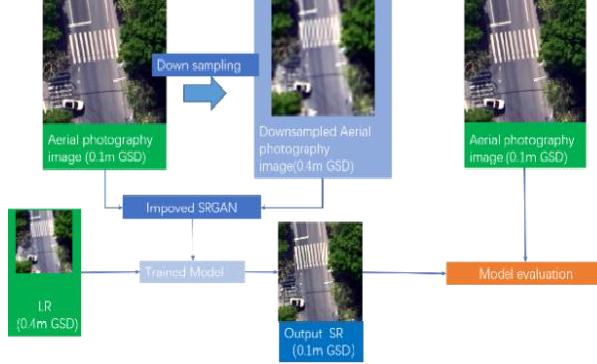
Figure 1. The flowchart of this paper